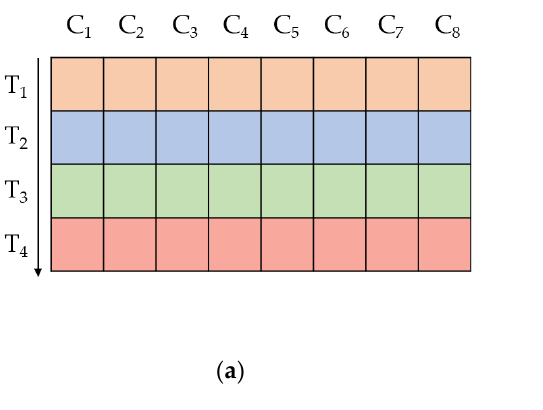
Figure 2. The working process of TSM. As shown in the picture, ( a ) shows a part of the characteristic diagram in the channel dimension and time dimension; ( b ) shows the working process of TSM. First, divide the feature map into two parts, moving the channel only in the first half and leaving the second half unchanged. For the moving part, the first-half channels move forward, and the last-half channels move backward for the moving part. Then, pad the empty part with “0”, and delete the extra part directly.